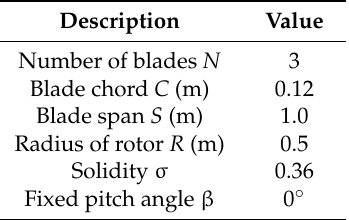
Table 1. Shape parameters of the vertical-axis turbine (VAT)